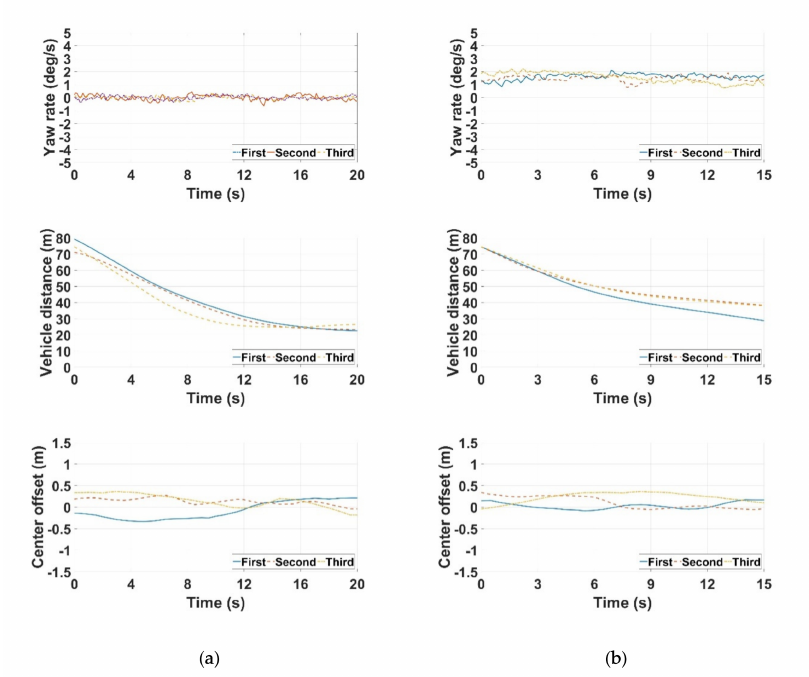
Figure 9. Yaw rate, distance to the lead vehicle, and distance to the center of the lane: ( a ) scenario 6 and ( b ) scenario